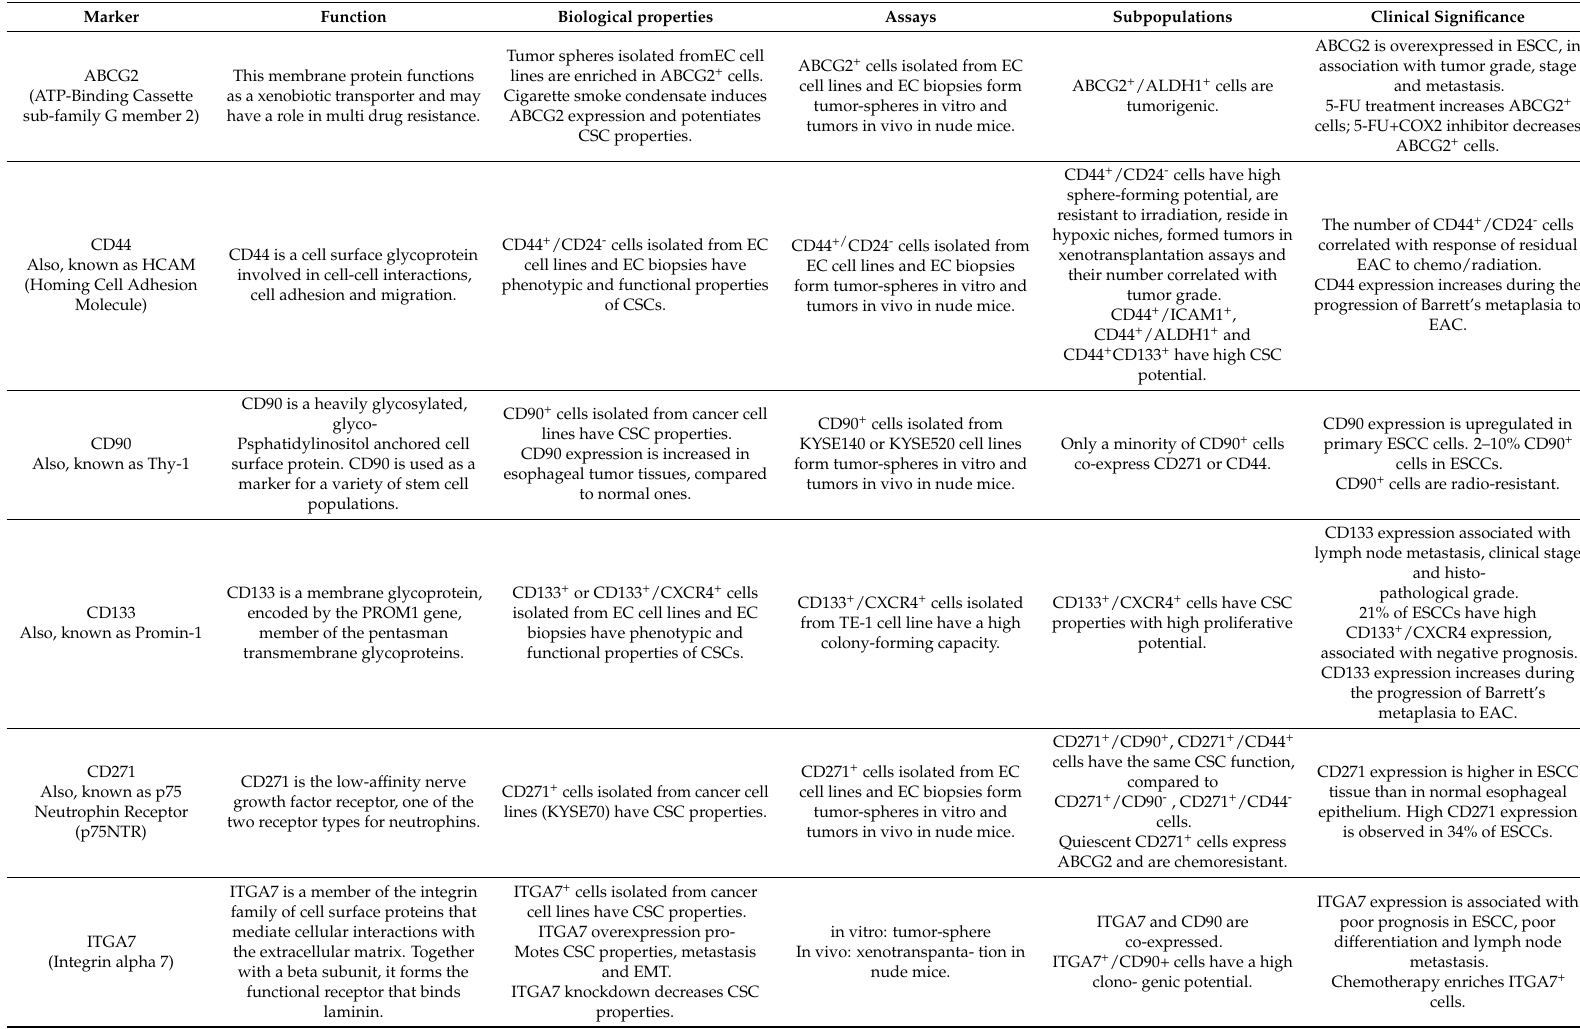
Table 1. Membrane markers of esophageal cancer stem